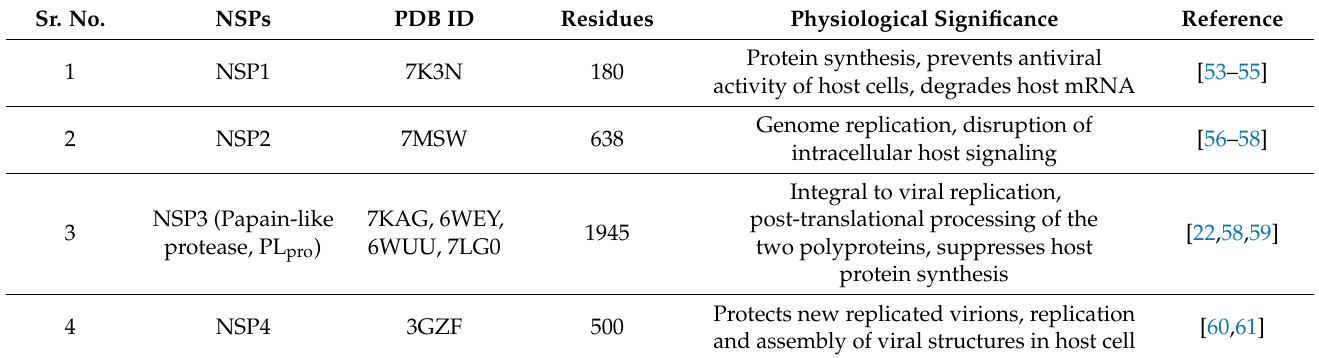
Table 2. The non-structural proteins (NSPs) of coronaviruses and their physiological significance. Sr.